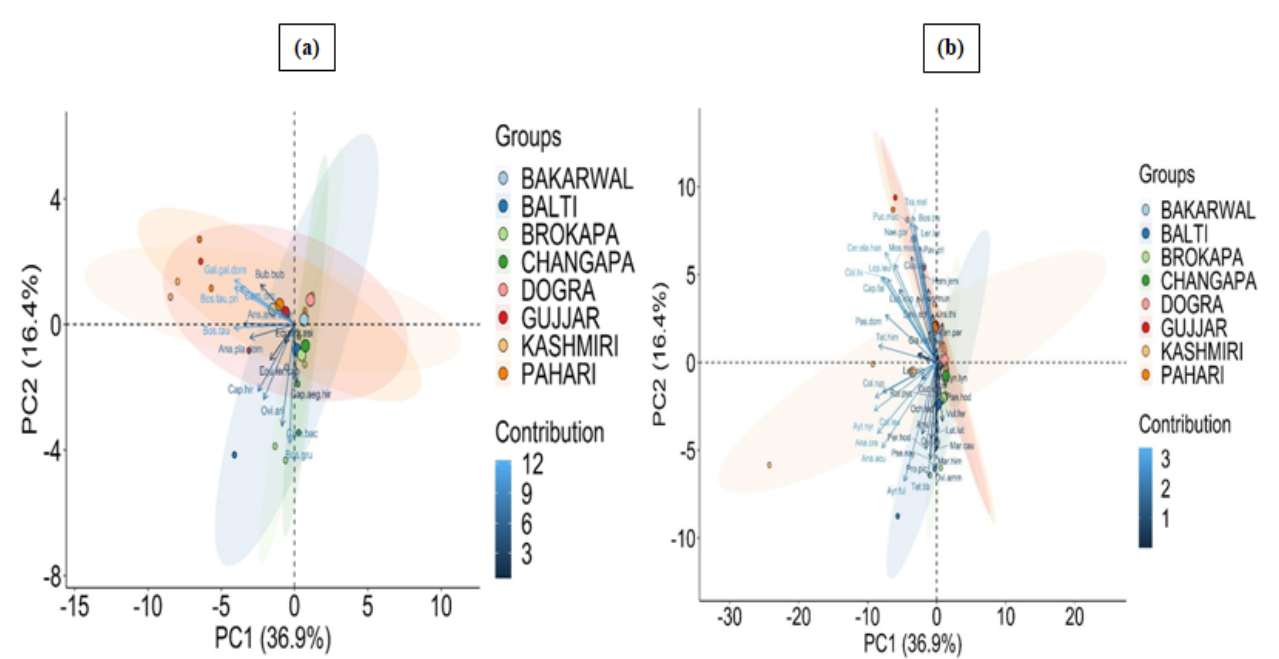
Figure 3. PCA diagram representing clustering of ( a ) wild; ( b ) domestic species among ethical groups. The complete name of the species is shown in Table 2.